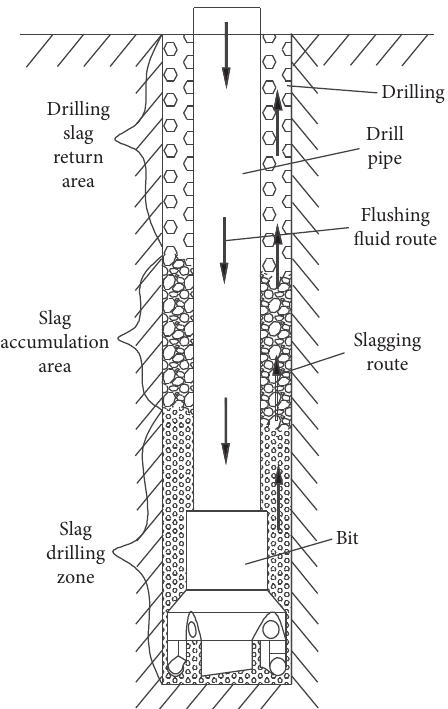
Figure 1: Diagrammatic sketch of flush fluid normal cycle deslagging in floor anchoring hole